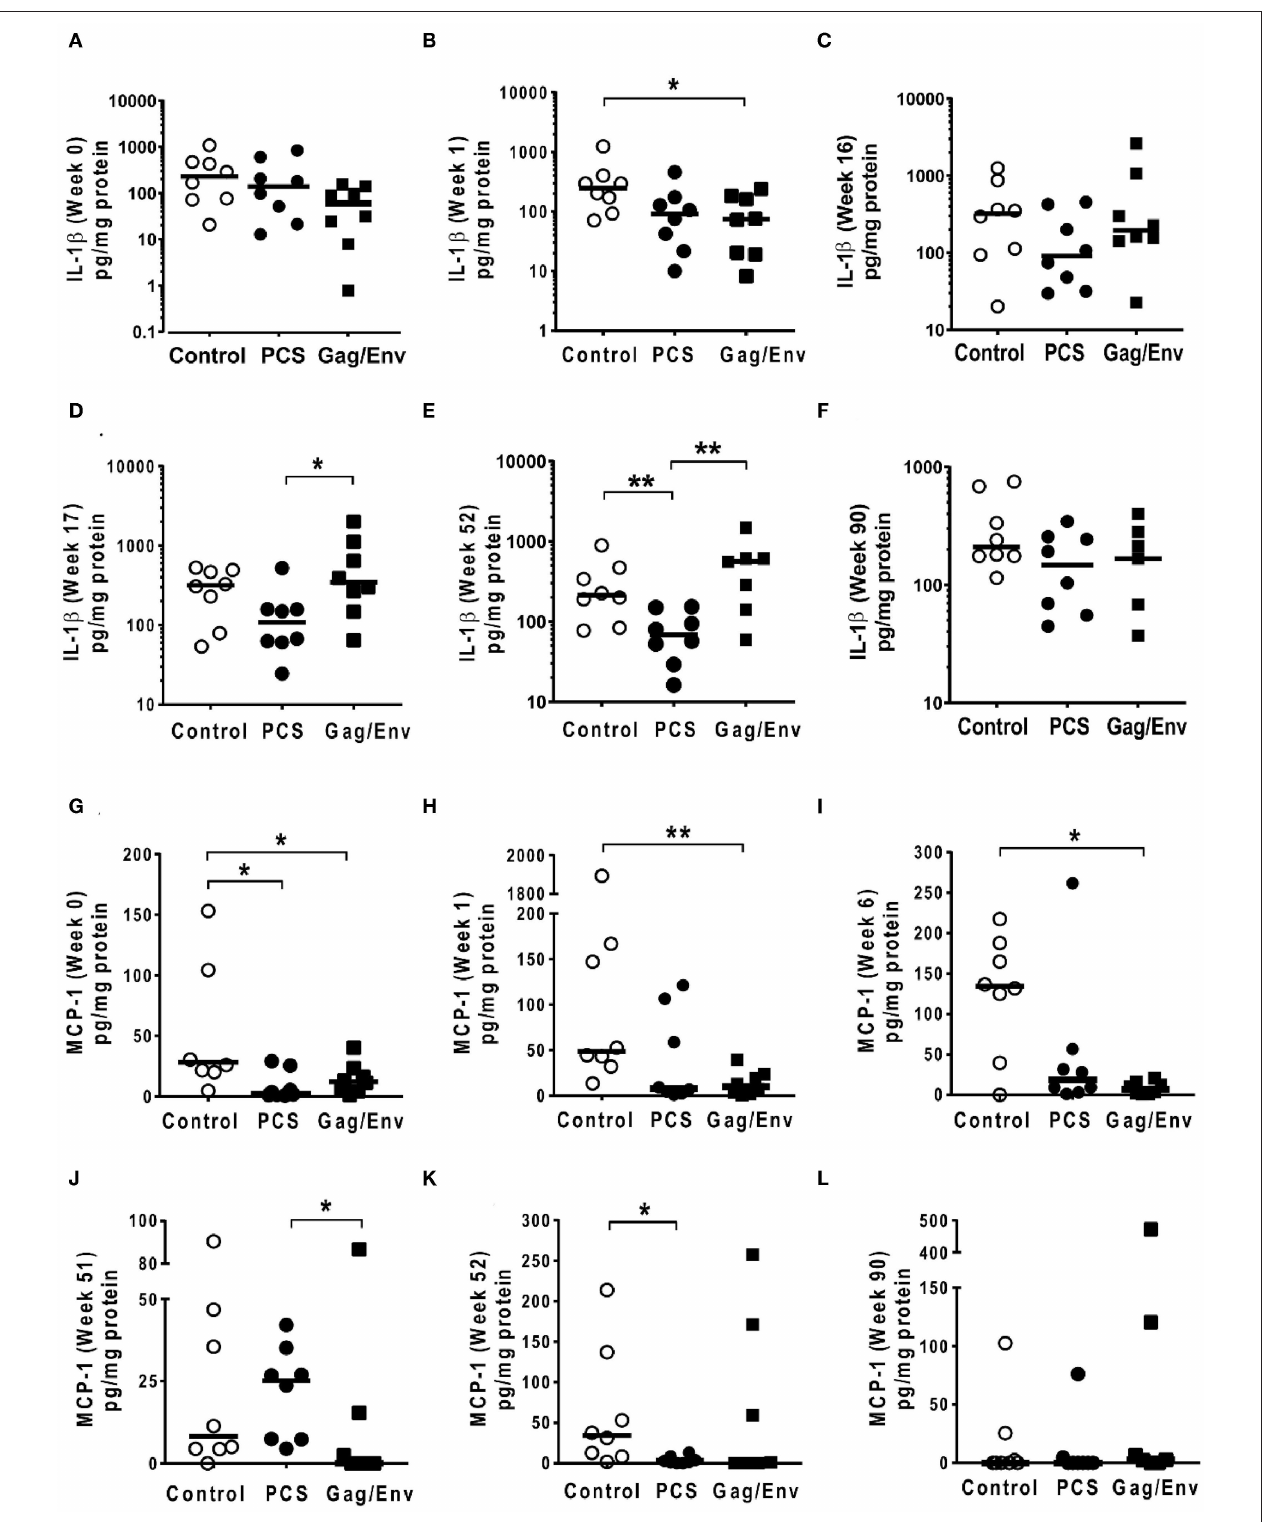
FIGURE 7 | Significant differences in CVL levels of IL-1 β and MCP-1 among the 3 vaccine groups at different time points including Week 0 and 90 analyzed using Mann-Whitney t -test. Data presented as values from individual monkeys with median. (A–F) IL-1 β (G–L) MCP-1. n = 8 monkeys/group ( n = 7 for Gag/Env). Experiments were run in duplicates. * P < 0.05 and ** P < 0.01. Non-significant differences between groups were not included.